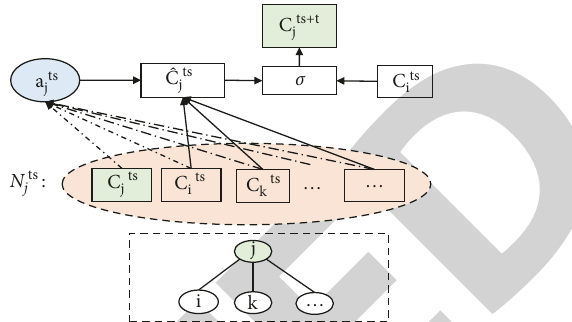
Figure 6: The graphical model of the road segment using the attention